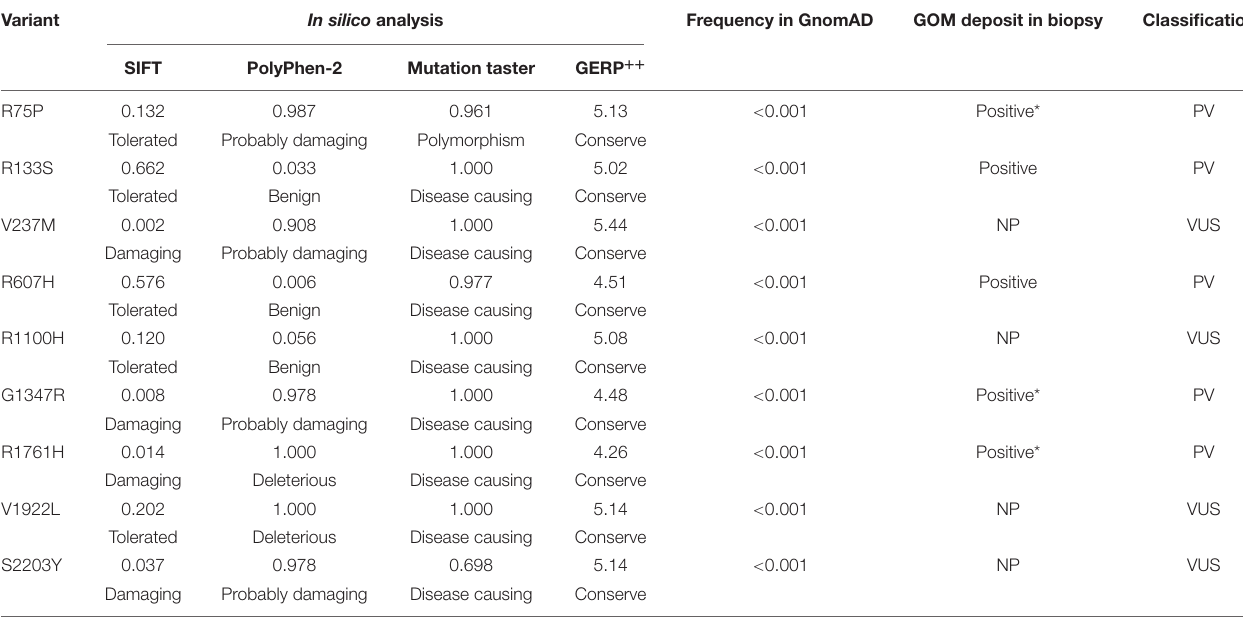
Damaging Probably damaging Disease causing